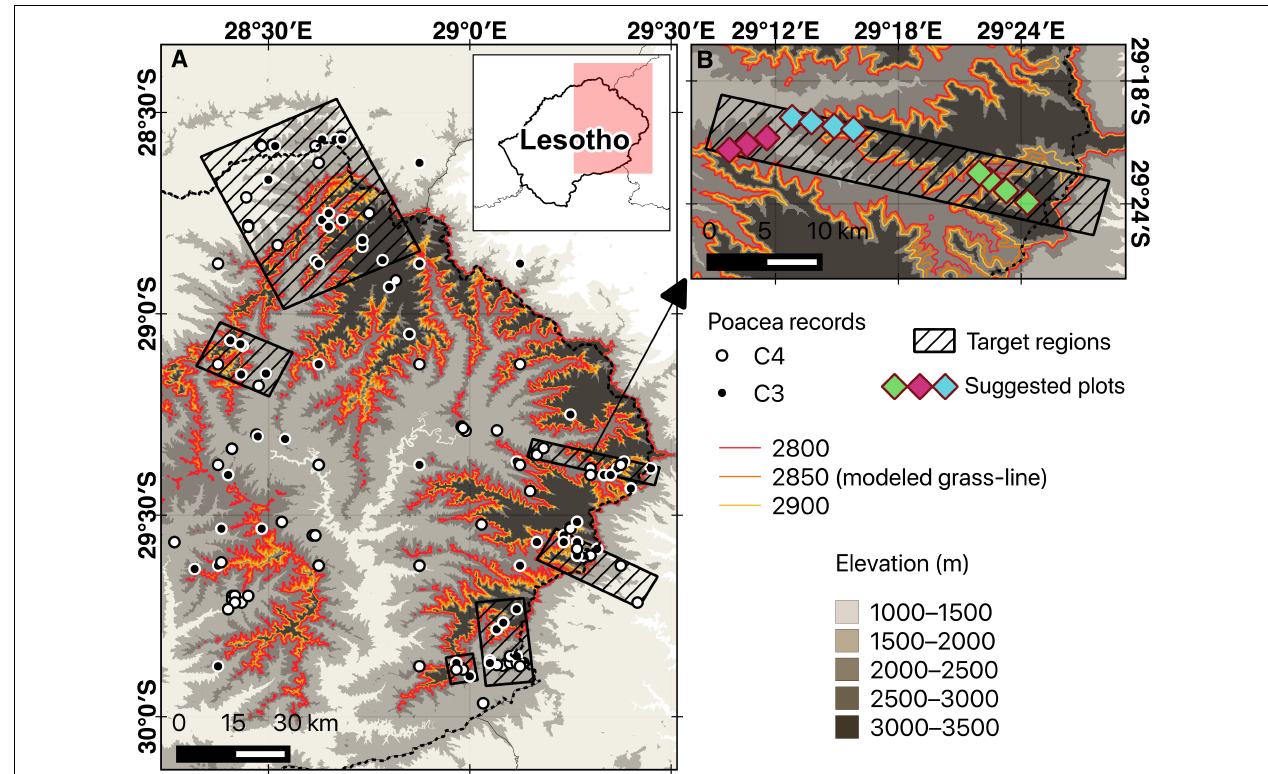
FIGURE 5 | Example of site selection for grass-line large and small plots using the Maloti-Drakensberg as a point in